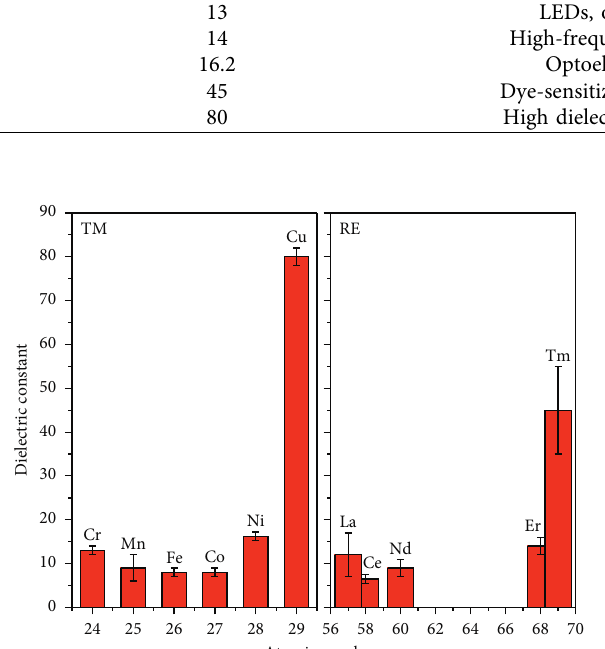
Figure 11: Dielectric constant of various metal-doped ZnO nanoparticles for 5% doping at 1MHz